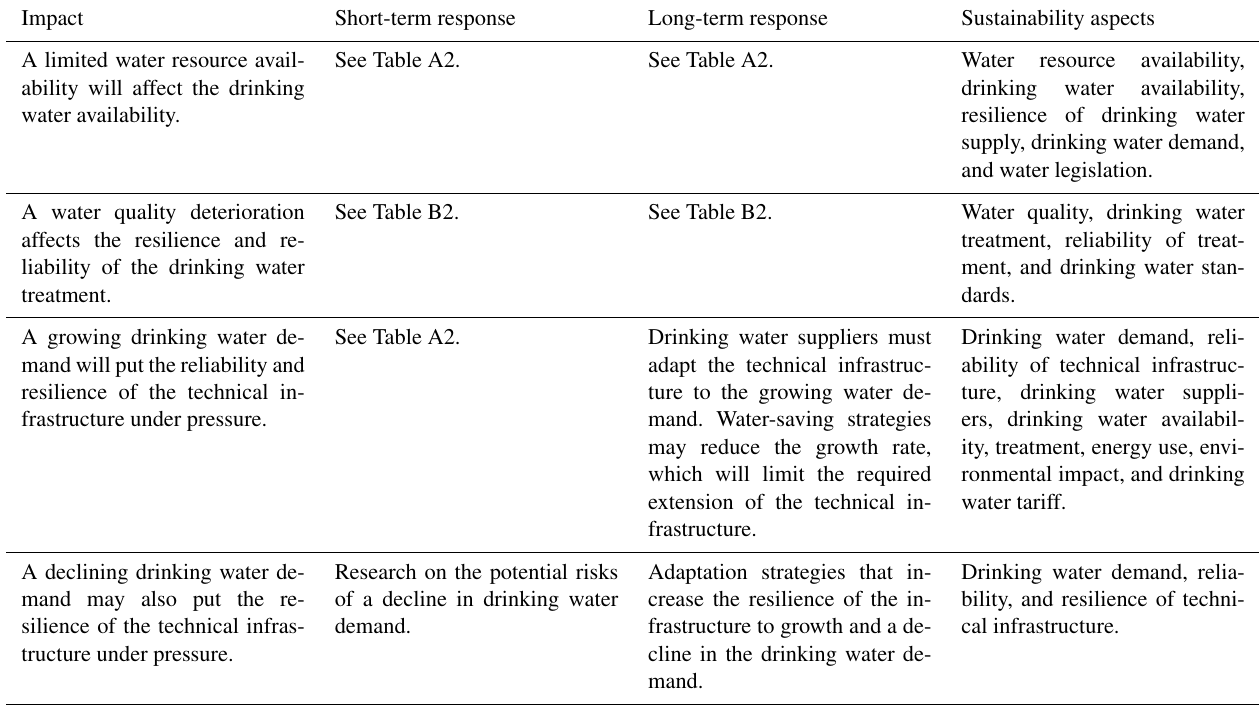
Table C1. Summary of the impact, short- and long-term response, and sustainability aspects in case 3 – drinking water demand growth (for complete results of the case study, see Table